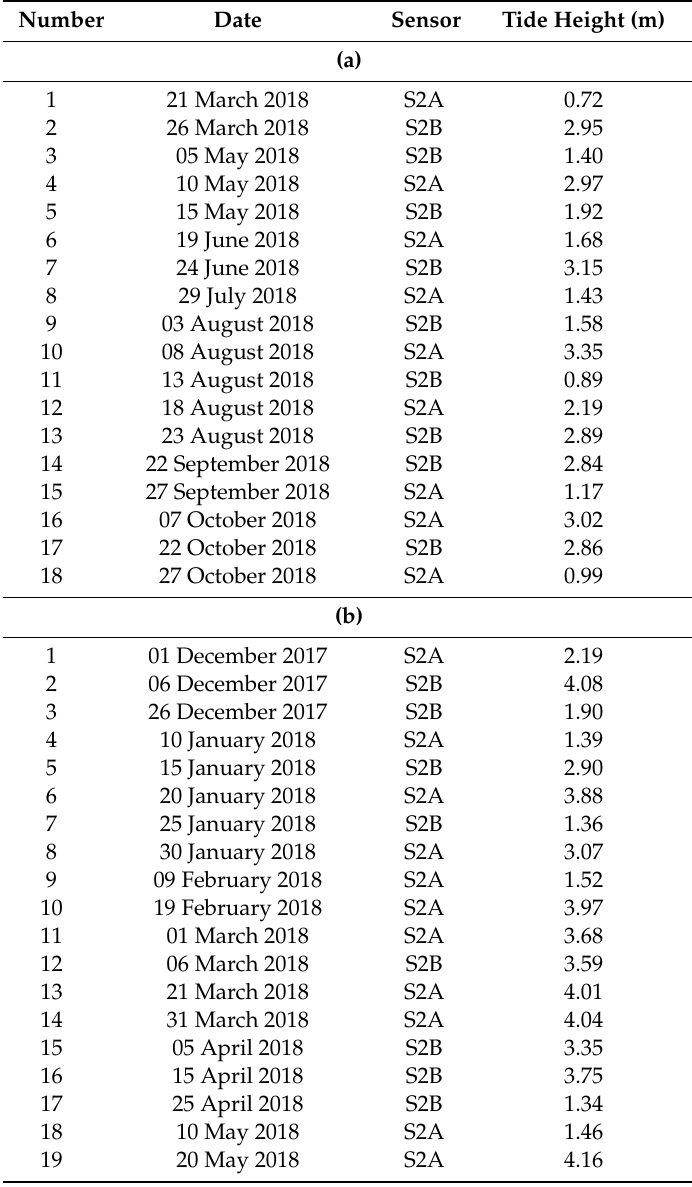
Table 1. List of Sentinel-2 A&B images used in this study for intertidal bathymetry extraction. Tide height (m) corresponding to image acquisition time (11:21 UTC). (a) Tagus estuary and (b) Bijag ó s